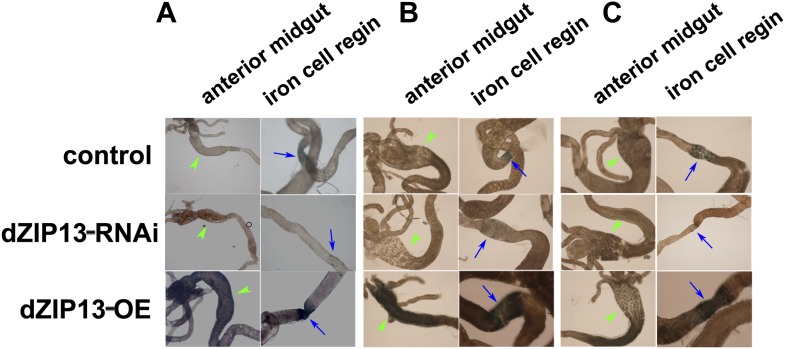
Staining of ferric iron in the larval gut.The ferric staining in the midgut constriction and the ectopic ferric staining in the anterior midgut are noted separately by arrows (blue) and arrow heads (green). The anterior midgut of NP3084>dZIP13-OE fly larvae deposited an obviously higher amount of iron than the control. Ferric iron accumulated prominently in the iron cell region of NP3084>dZIP13-OE while NP3084>dZIP13-RNAi larvae showed almost no iron staining. (A), (B) and (C) are results from three independent experiments.